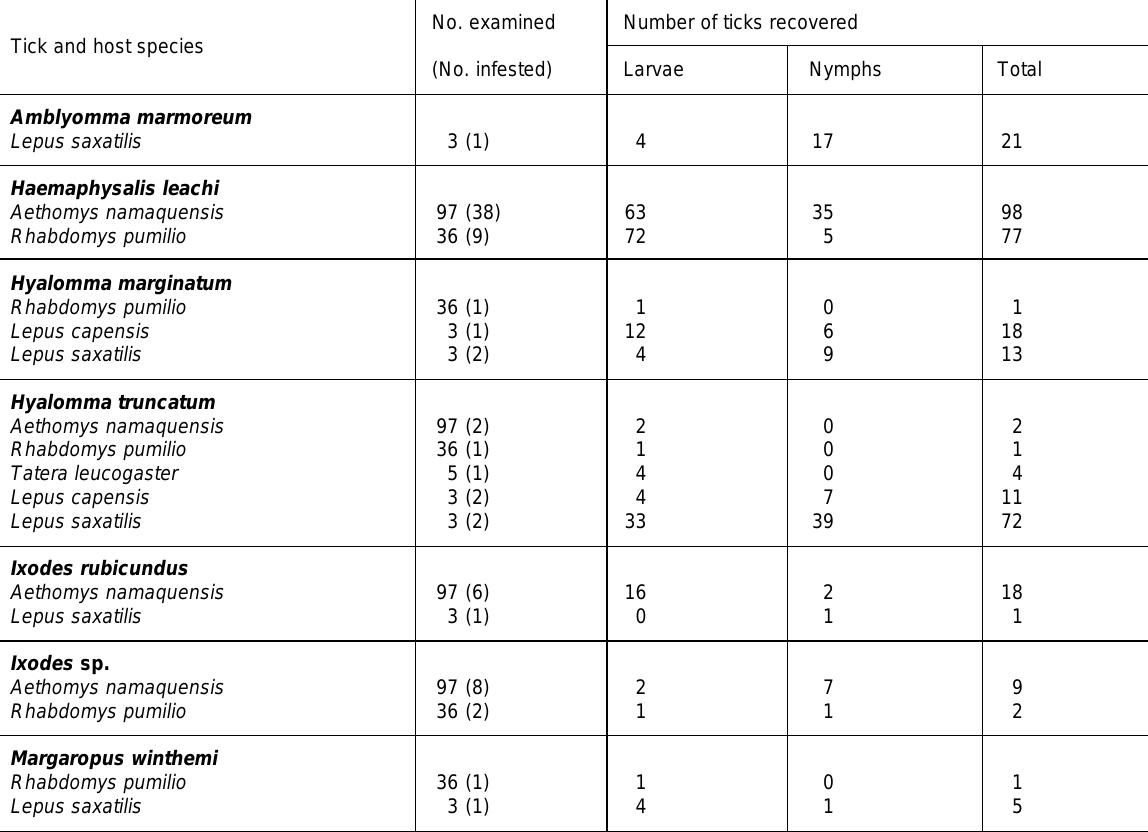
TABLE 2 Ticks, other than Rhipicephalus species, on small mammals in Free State Province No. examined